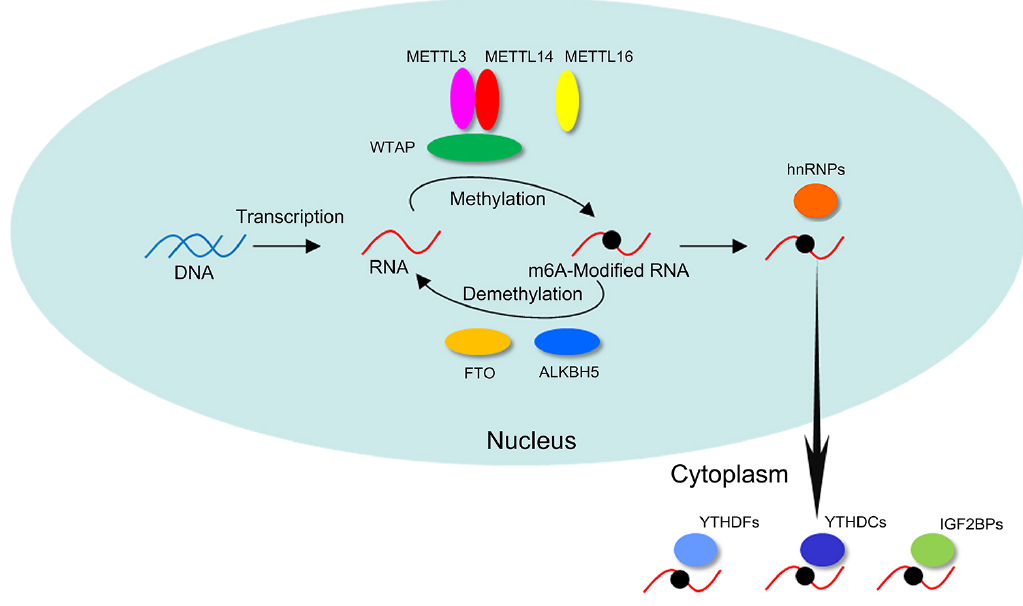
Figure 1 – The m6A modification process. METTL3, METTL14, WTAP, and METTL16 are methyltransferases, termed as “writers,” involved in m6A modification in the nucleus. FTO and ALKBH5 are demethylases, termed as “erasers.” YTHDFs, YTHDCs, and IGF2BPs are methylated reader proteins, referred to as “readers,” located in the cytoplasm. Writers mediate m6A methylation, which is a post-transcriptional process in RNA. Erasers catalyze the demethylation of m6A, which reverses methylation. Readers recognize m6A modifications, which play a role in mRNA decay and translation.